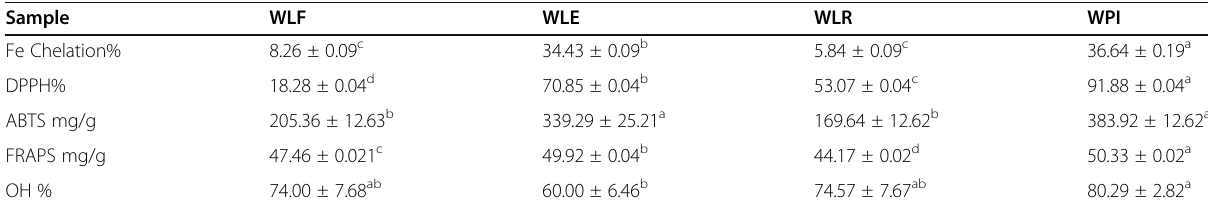
Table 5 Antioxidant activities of African wild lettuce leaf samples Sample